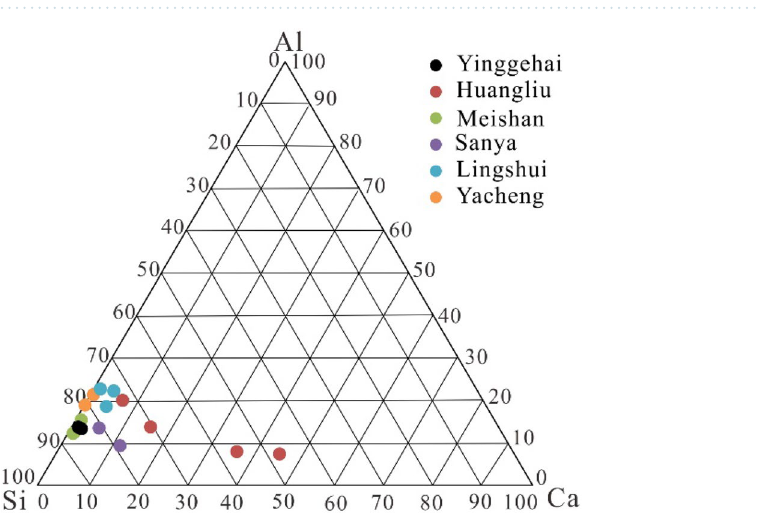
Figure 3. Normalized major elements of the upper continental crust 43 of Cenozoic sediment samples obtained from five wells in the junction area of Yinggehai and Qiongdongnan basins.